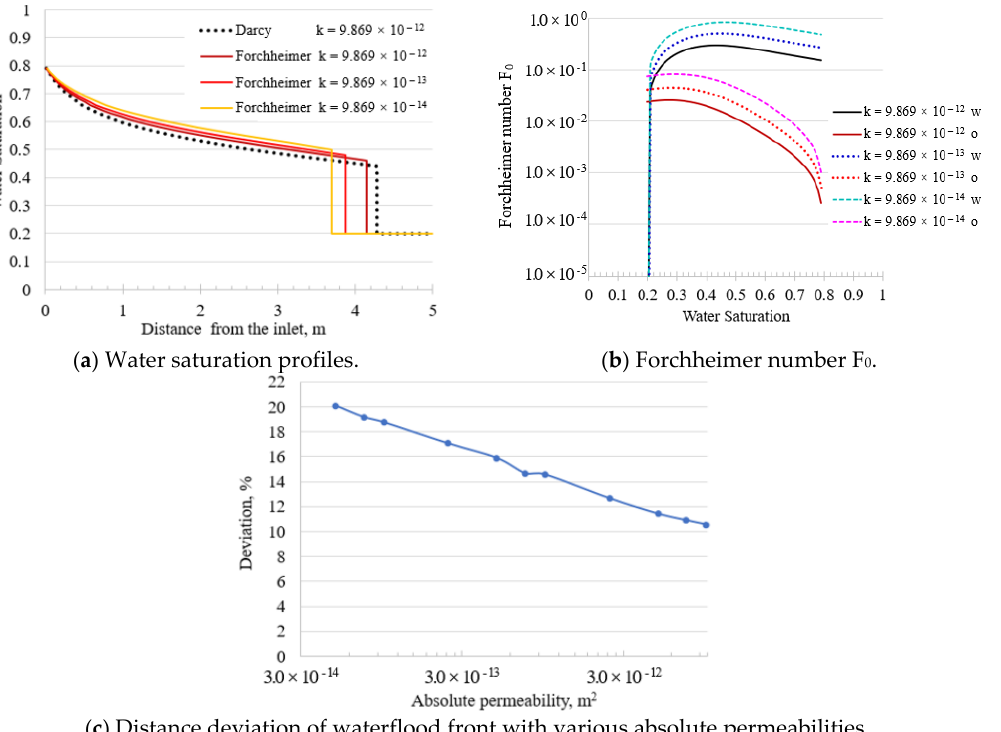
Figure 9. Comparison of Darcy vs. Forchheimer equations with various absolute permeabilities.